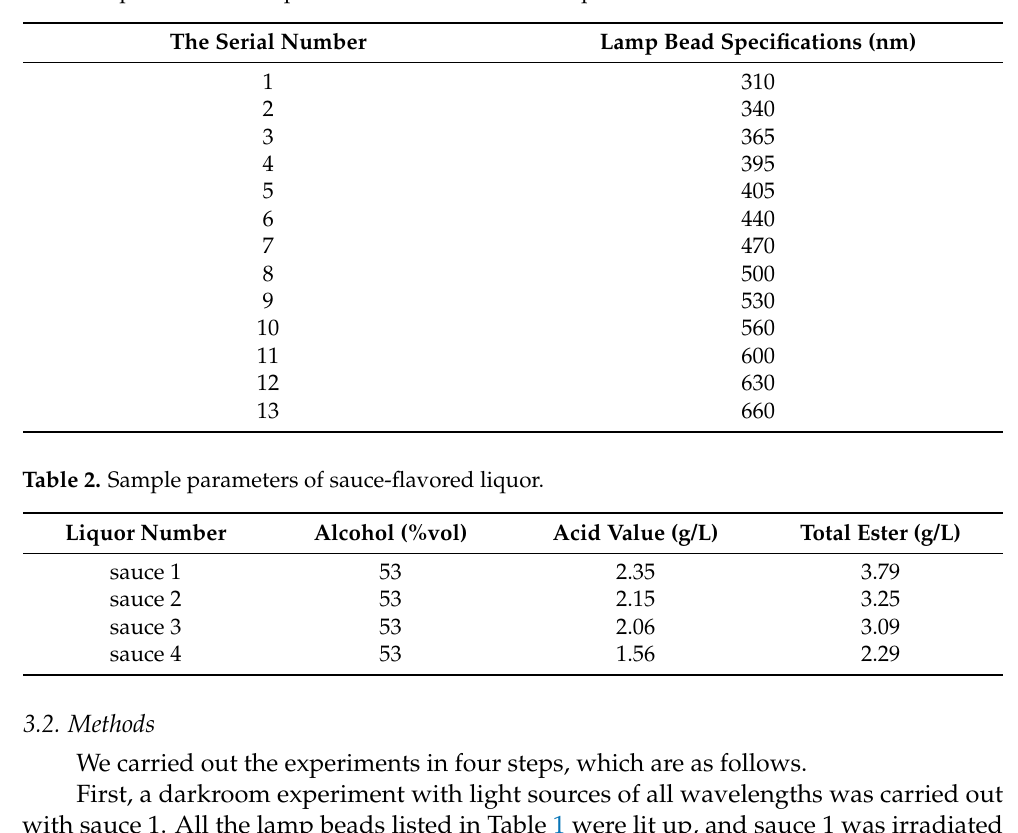
Table 1. Specifications of spherical vertical structure lamp beads.